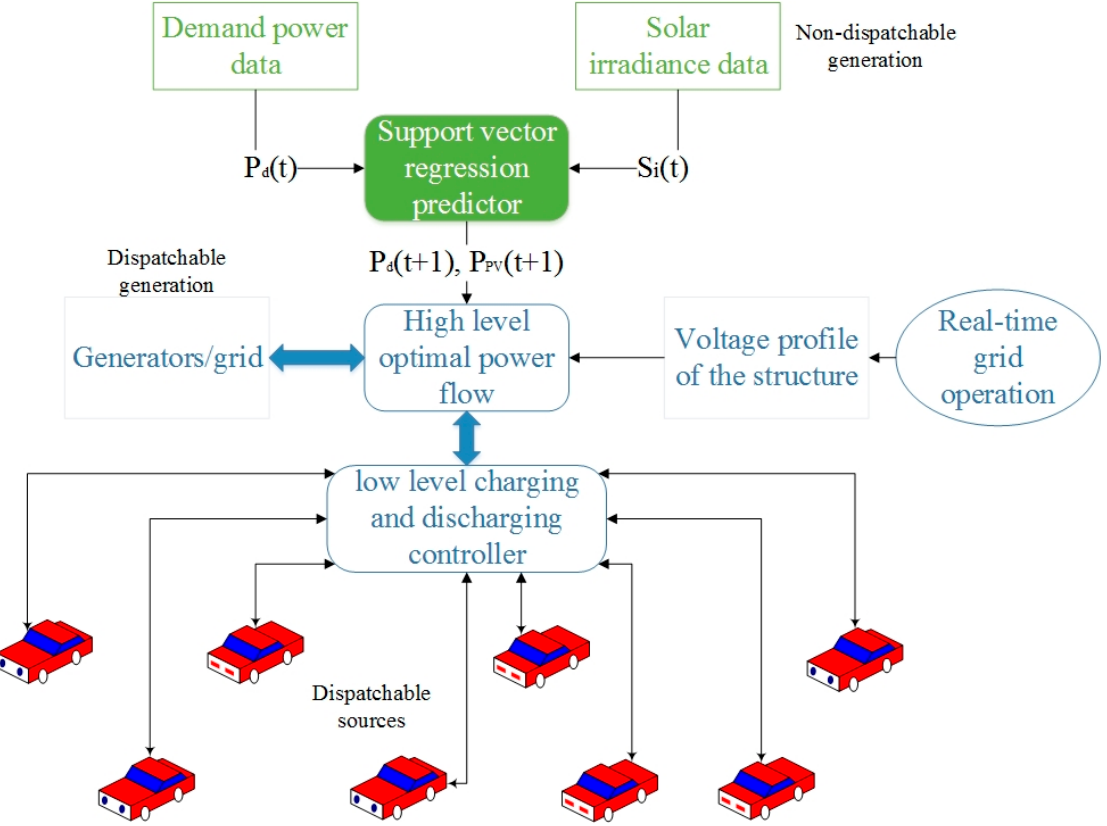
Figure 2. Hierarchical control scheme and the aggregator.